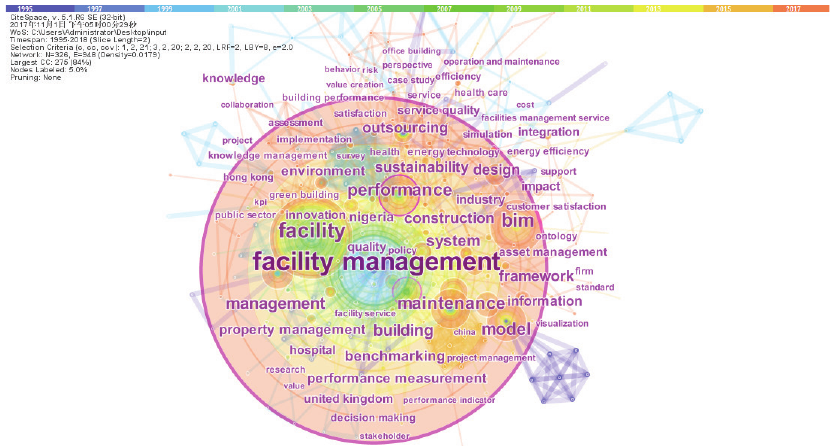
Figure 2. Keyword co-occurrence network of FM: 1995–2018